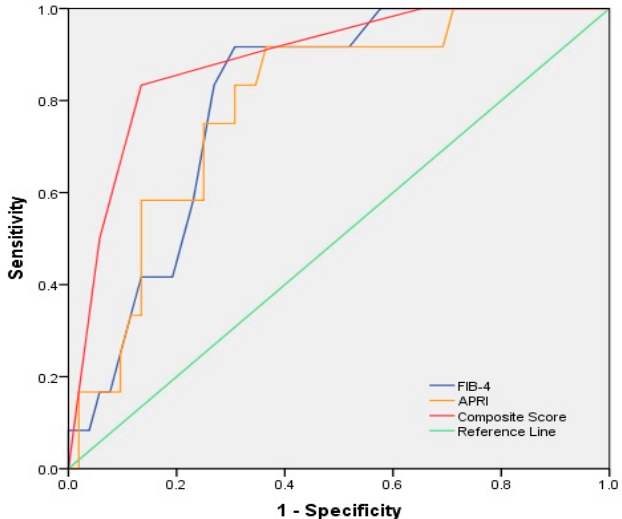
Figure 2. Receiver operating characteristic (ROC) curves for FIB ‐ 4, APRI, and composite score for the detection of F3/F4 group of patients.